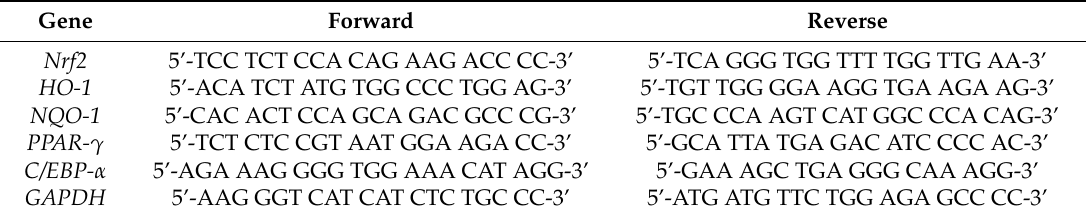
Table 1. Human primers for Polymerase Chain Reaction